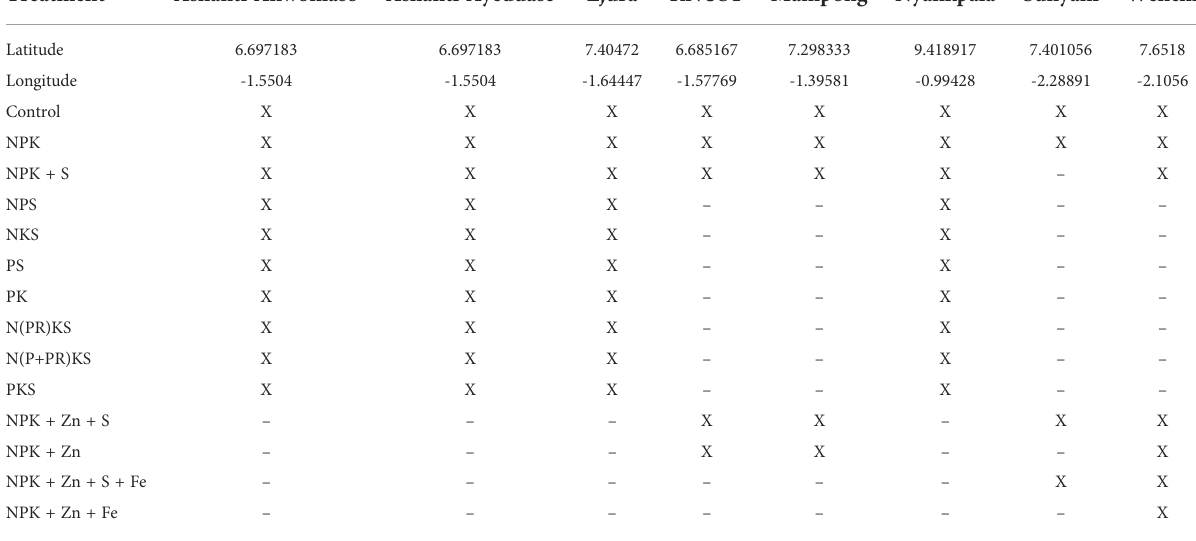
TABLE 1 Fertilizer treatments applied on the study sites. Treatment